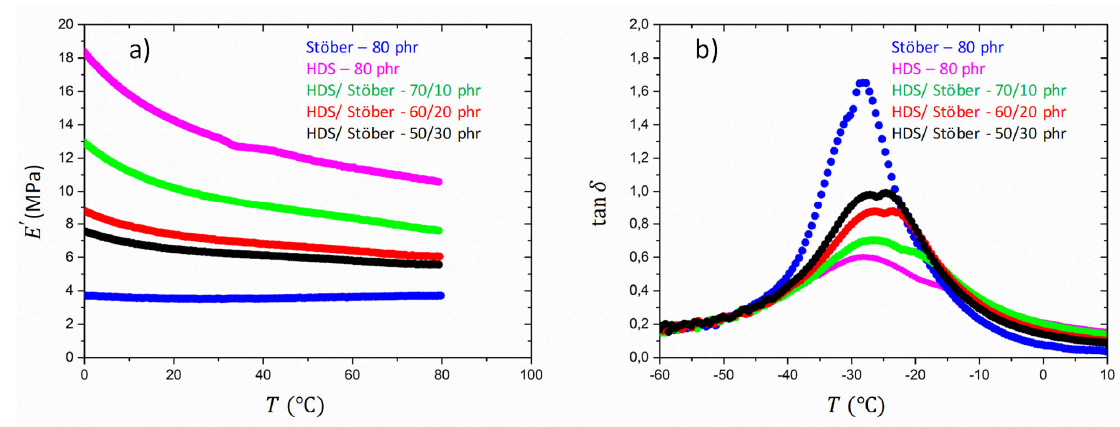
Figure 7. Plot of 𝐸 (cid:4593) ( a ) and 𝑡𝑎𝑛 𝛿 ( b ) versus temperature for reference SBR samples and dual fillers Scheme 10. phr (R ‐ 31), Stöber/HDS ‐ 20/60 phr (R ‐ 32), Stöber/HDS ‐ 30/50 phr (R ‐ 33).